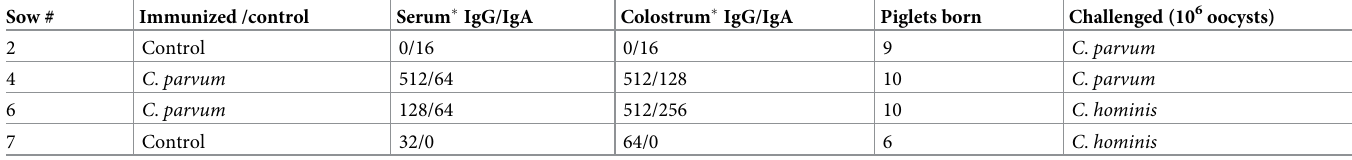
Table 1. Summary of immunization of pregnant sows, their ELISA antibody titers, the number of piglets born to each, and the dose and parasite species the piglets were challenged with. Sow